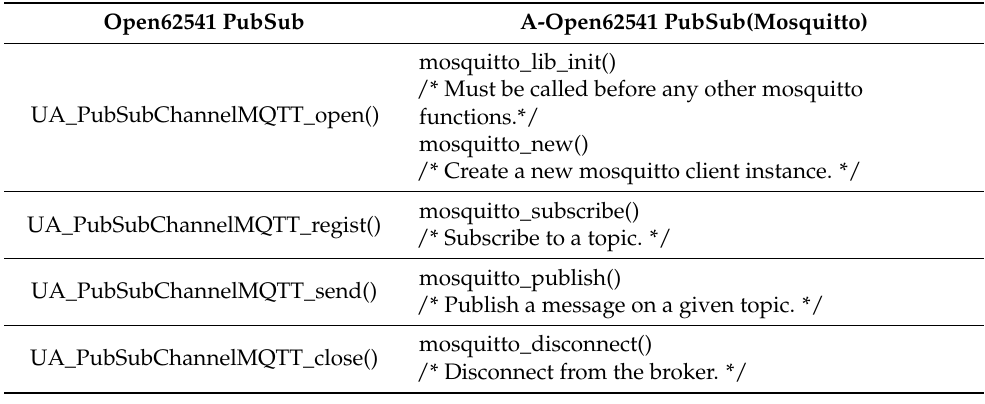
Table 4. A-Open62541 PubSub Mosquitto API.